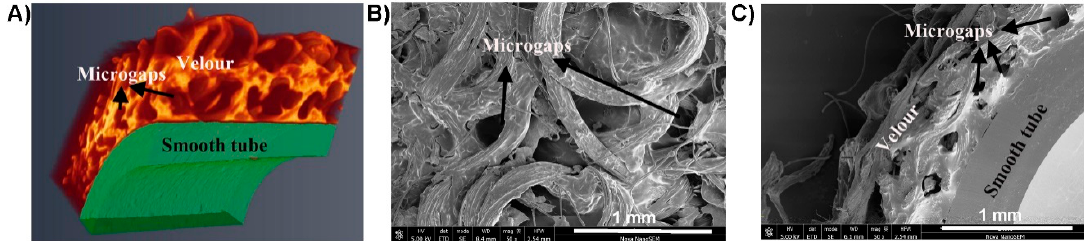
Figure 5. The presence of microgaps in the driveline tissue tunnel. ( A ) Micro-CT image of an explanted driveline shows numerous microgaps in the sectioned velour; ( B ) Scanning electron microscopy (SEM) of the velour (top-bottom view) shows microgaps [9]; ( C ) SEM of the explanted driveline (cross-section view) also shows numerous microgaps within the velour, suggesting insufficient tissue integration [9]. Reprinted from Reference [9], Copyright (2020), with permission from Elsevier.